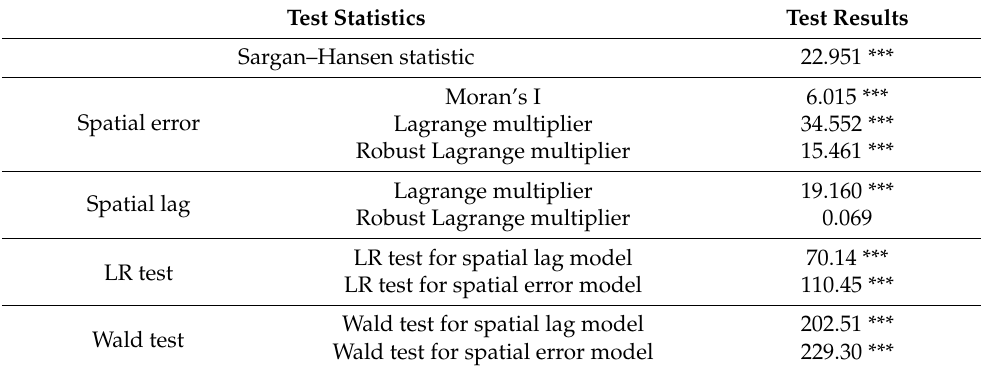
Table 6. Diagnostic tests on the spatial panel data